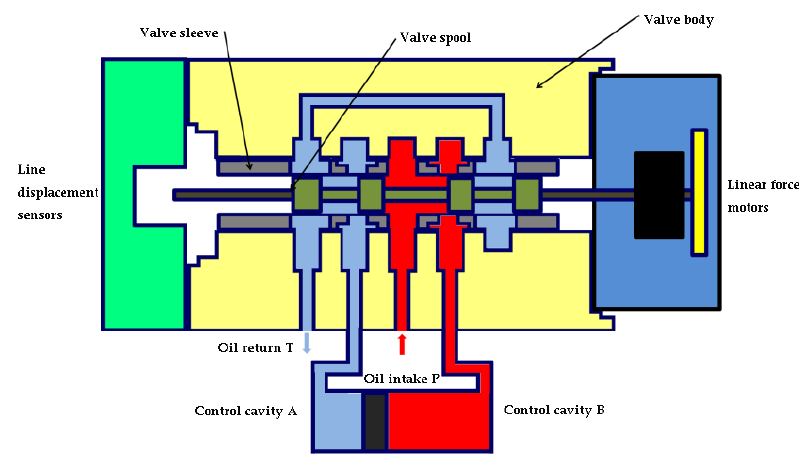
Figure 4. Spool moves to the right; right-hand inlet opens.